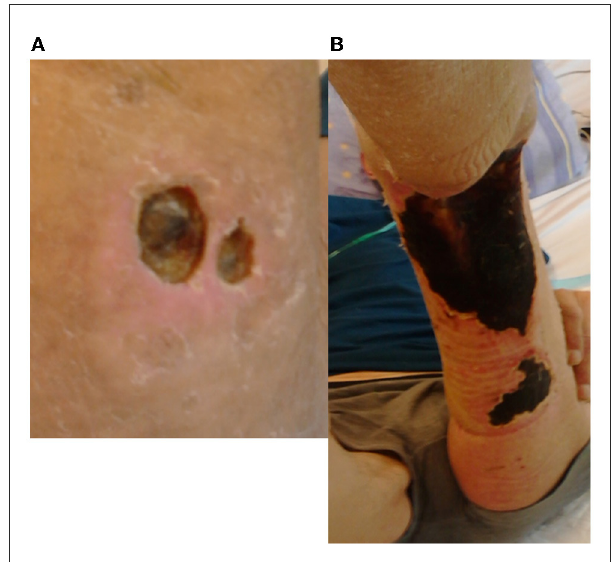
FIGURE1 Clinical presentation of cutaneous tuberculosis as a necrotizing ulcer: (A) initial painless plaque and edema with ulceration; (B) developed diffuse ulcer. Unlike in scrofuloderma, enlarged lymph nodes were not observed in this case. Although asthenia and weight loss were observed, neither crusts nor plaques were observed. Deep ulcers cause scarring of muscles and tendons and finally permanent disability. Cloth necrosis but without purulent exudate was found (A) . The painless ulcer turned black (possibly due to dyscrasia, hyperviscosity, and hemolysis (B) . After the therapeutic regimen, the ulcer has not developed